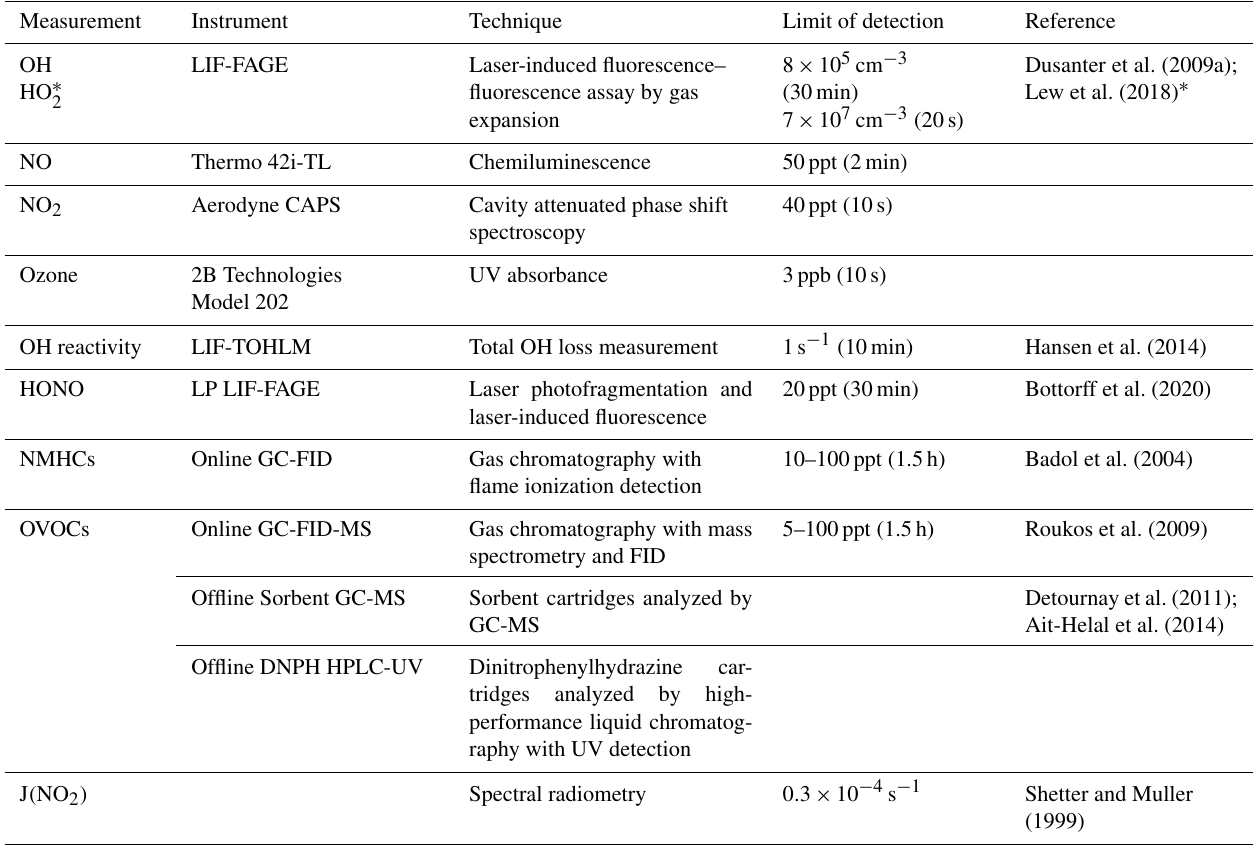
Table 1. Measurements conducted during the IRRONIC field campaign.